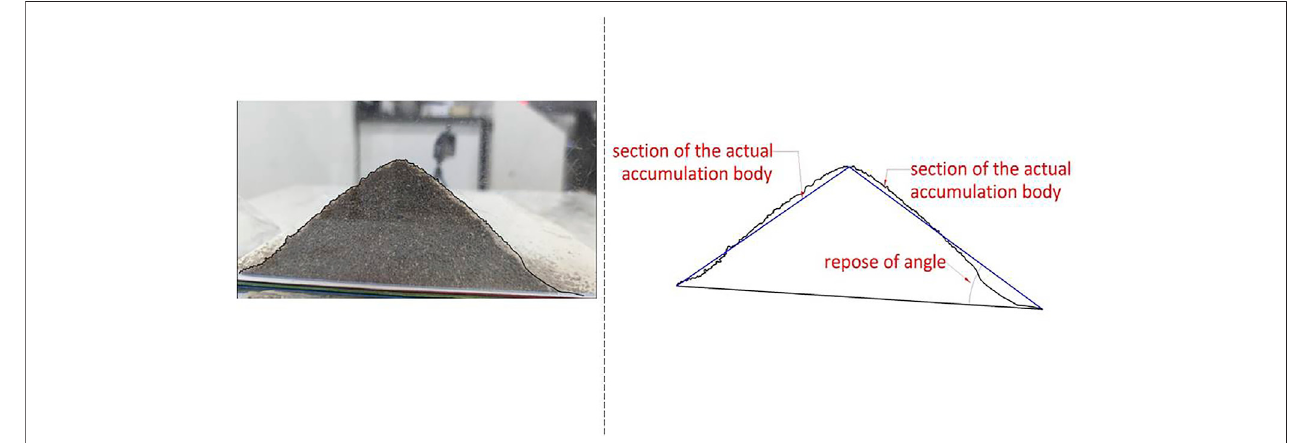
FIGURE 6 | Accumulation body and measured